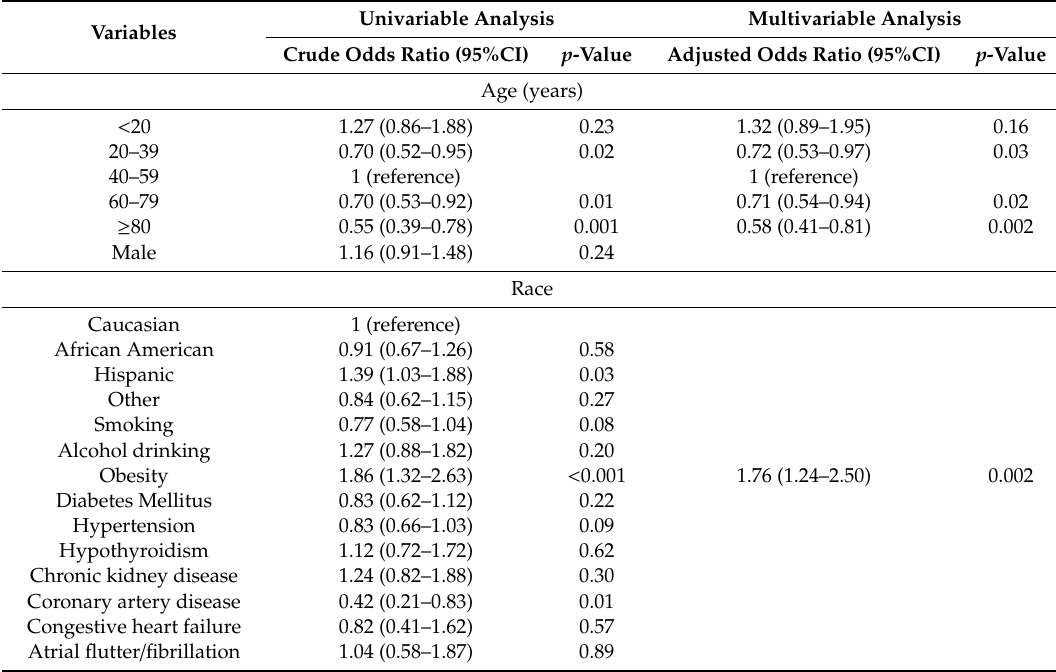
Table 2. Univariable and multivariable analysis assessing factors associated with circulatory failure in heatstroke patients.